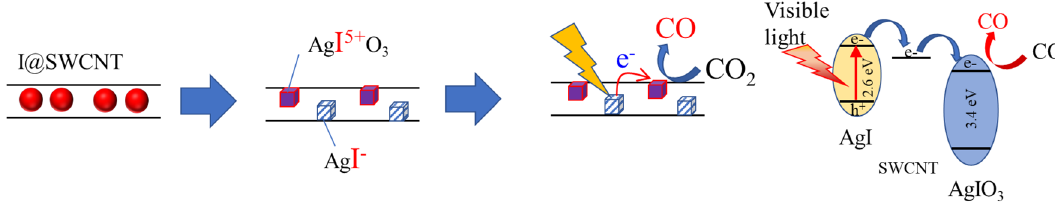
Figure 1. Schematic picture of the synthesis procedure of the three-component composite of AgI, AgIO 3 , and SWCNTs. The photocatalytic mechanism scheme of the composite under irradiation of visible light is also